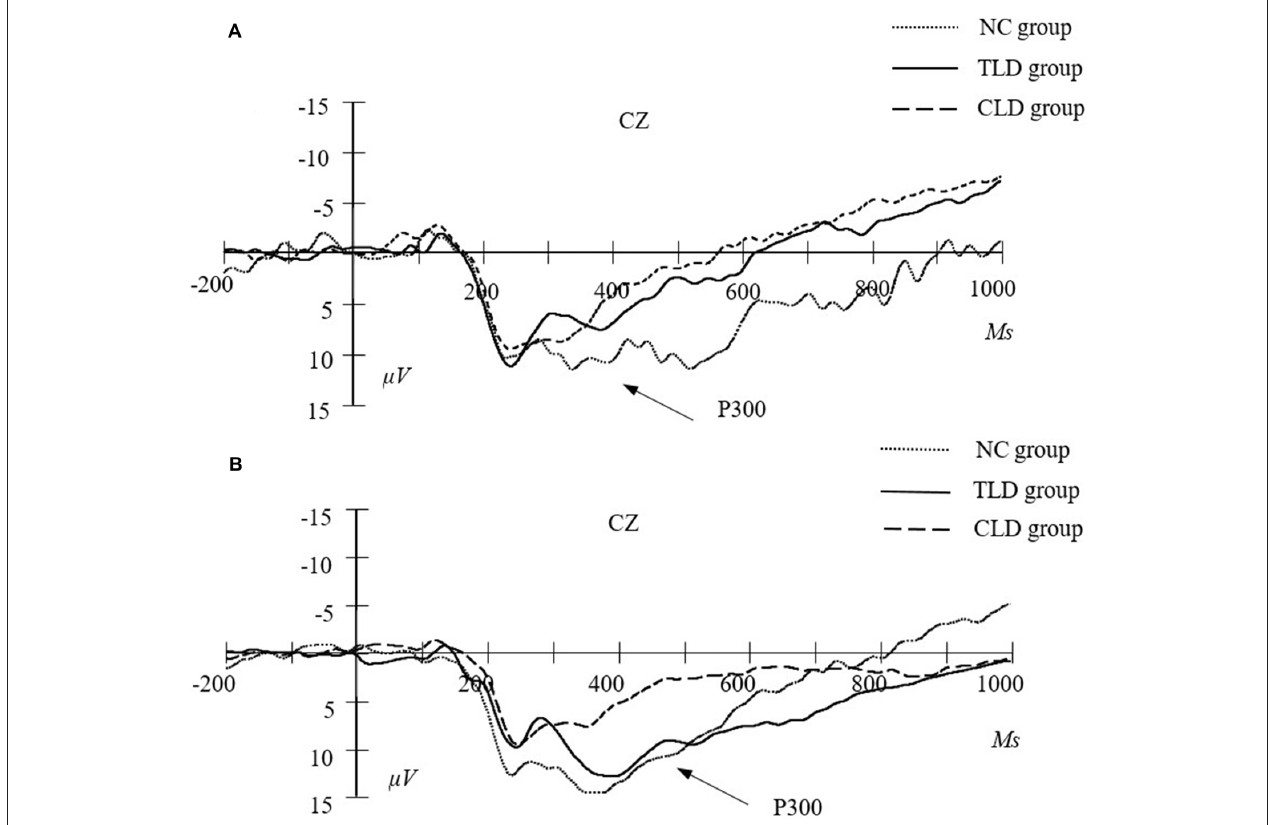
FIGURE 6 | The average amplitude of P300 in central area at pretest (A) and posttest (B) for each group.